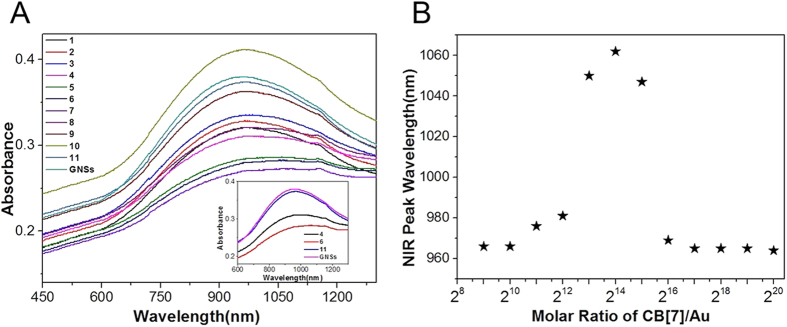
(A) UV-vis-NIR spectrum of the CB[7]-GNSs with CB[7]/Au ratio = (1) 29, (2) 210, (3) 211, (4) 212, (5) 213, (6) 214, (7) 215, (8) 216, (9) 217, (10) 218 and (11) 219 by addition of CB[7]; (B) NIR peak wavelength as functions of CB[7]/Au ratio.